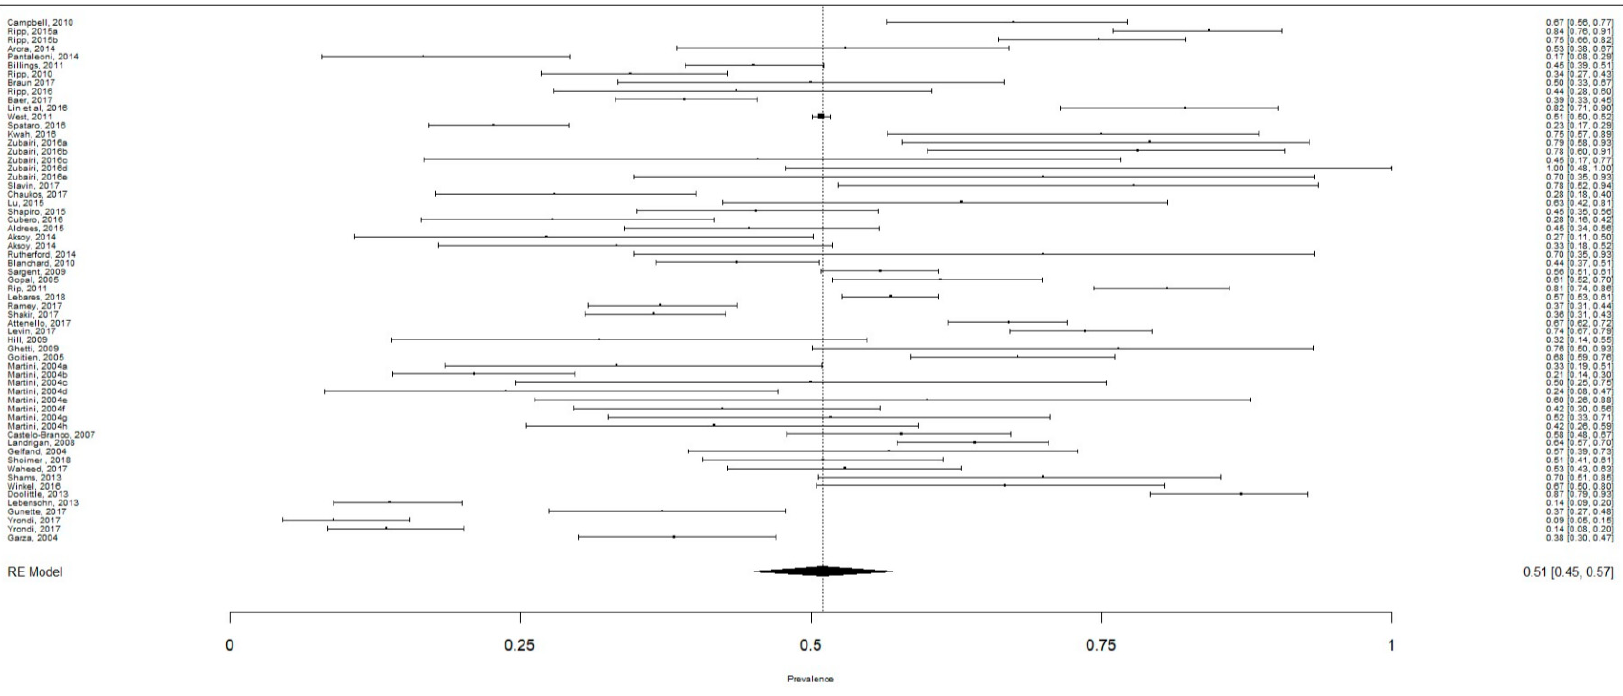
Figure 2. The aggregate prevalence of burnout in all residents.